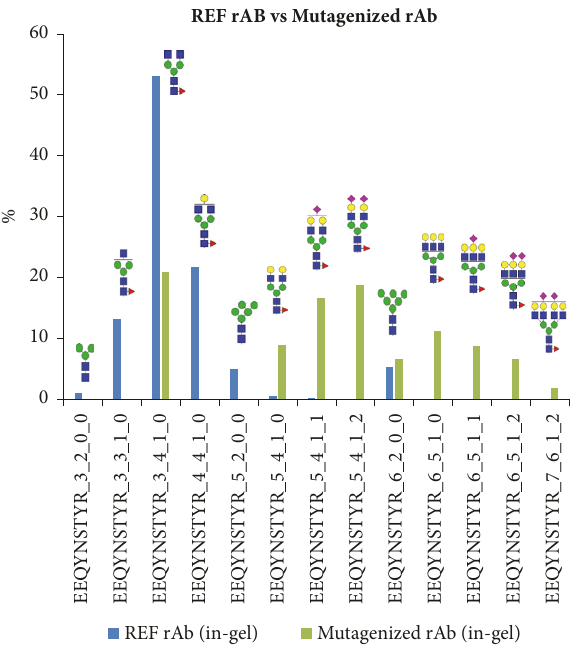
Figure 8: Comparative glycopeptide mapping of the reference rAb and the mutagenized rAb glycoprotein by in-gel digestion and LC- ESI-MS/MS. Each dataset was normalized before comparative anal- ysis. Glycosylation patterns were notably different between the ref- erence rAb and the mutagenized rAb samples. Increased abundance of sialylation, galactosylation, and branching was observed in the mutagenized rAb in comparison to the reference rAb